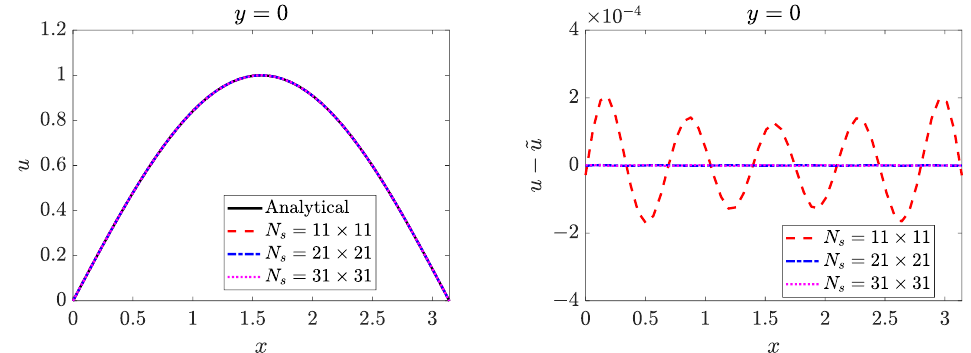
Figure 15. Solution and corresponding error for the 2D varying parameter identification problem.